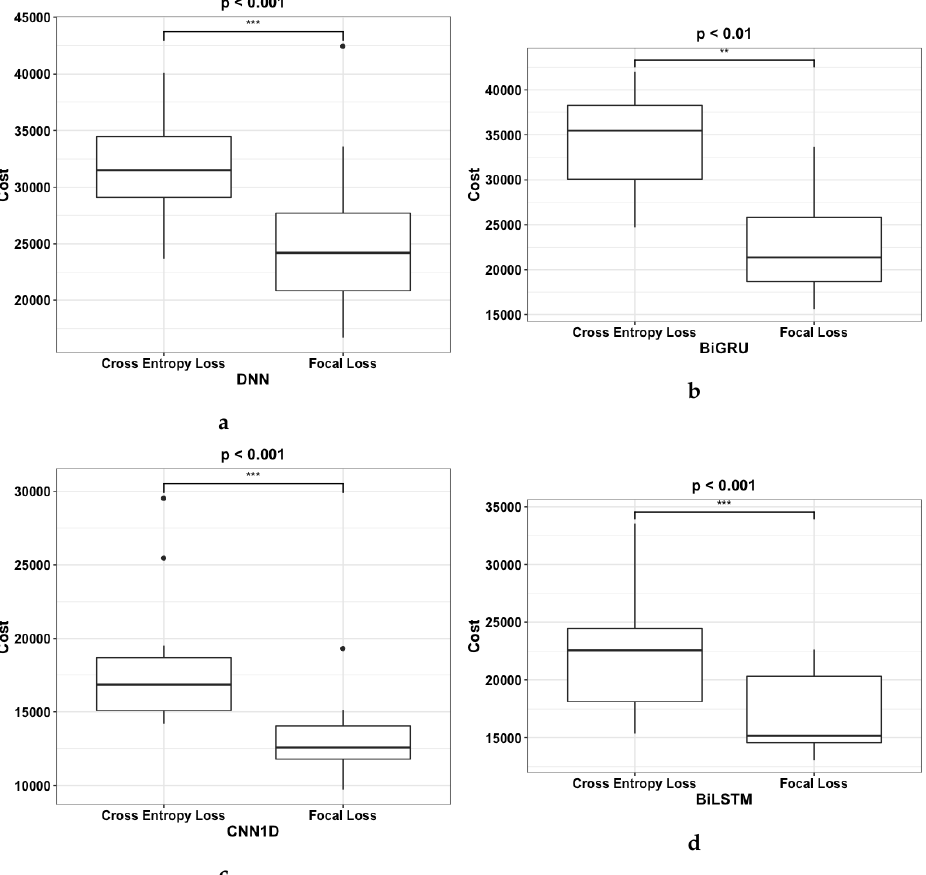
Figure 13. Boxplots of Costs result from using ( a ) DNN, ( b ) BiGRU, ( c ) CNN1D, and ( d ) BiLSTM with CE and FL respectively. The asterisk on the top of each boxplot denotes the p -value where “***” < 0.001, “**” < 0.01, “*” <